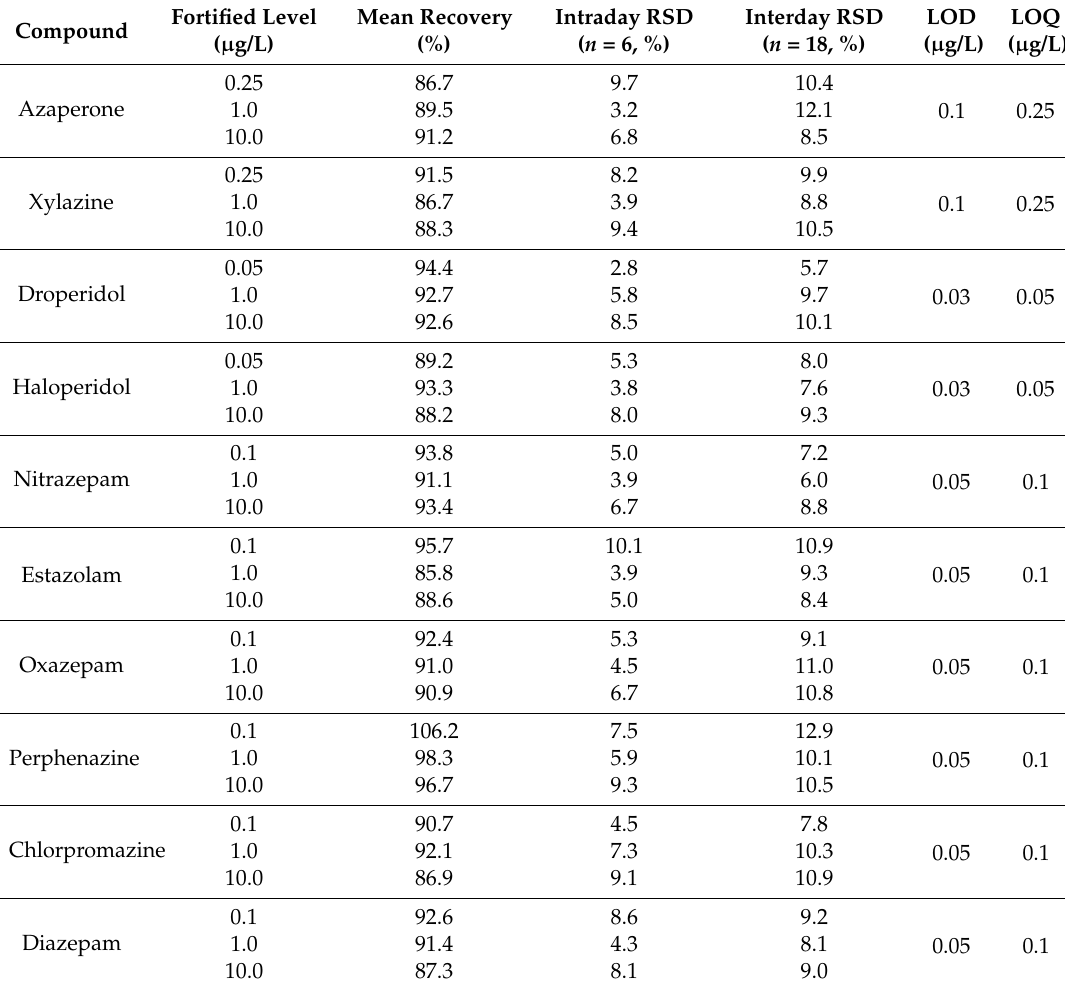
Table 1. Recovery, precision, and sensitivity of the